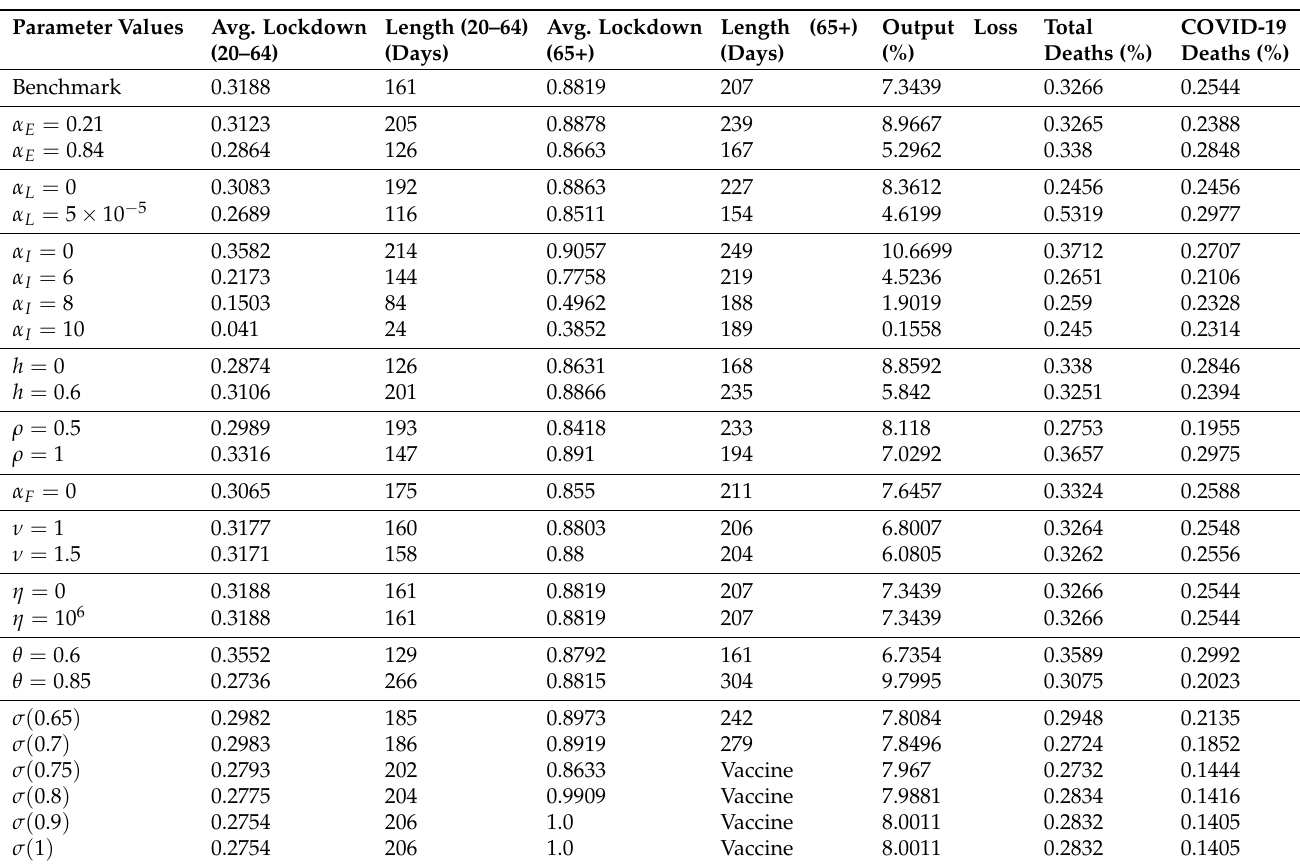
Table 4. Parameter robustness results (note: lockdown for 65+ ends at herd immunity). Benchmark parameters: χ = 10/ r , r = 0.001%, α E = 0.42, h = 0.4, α L = 10 − 5 , α I = 1, ρ = 0.75, F = 1, θ = 0.75, ν = 0.67, η = 10. Death rates from Table 1. herd immunity threshold =